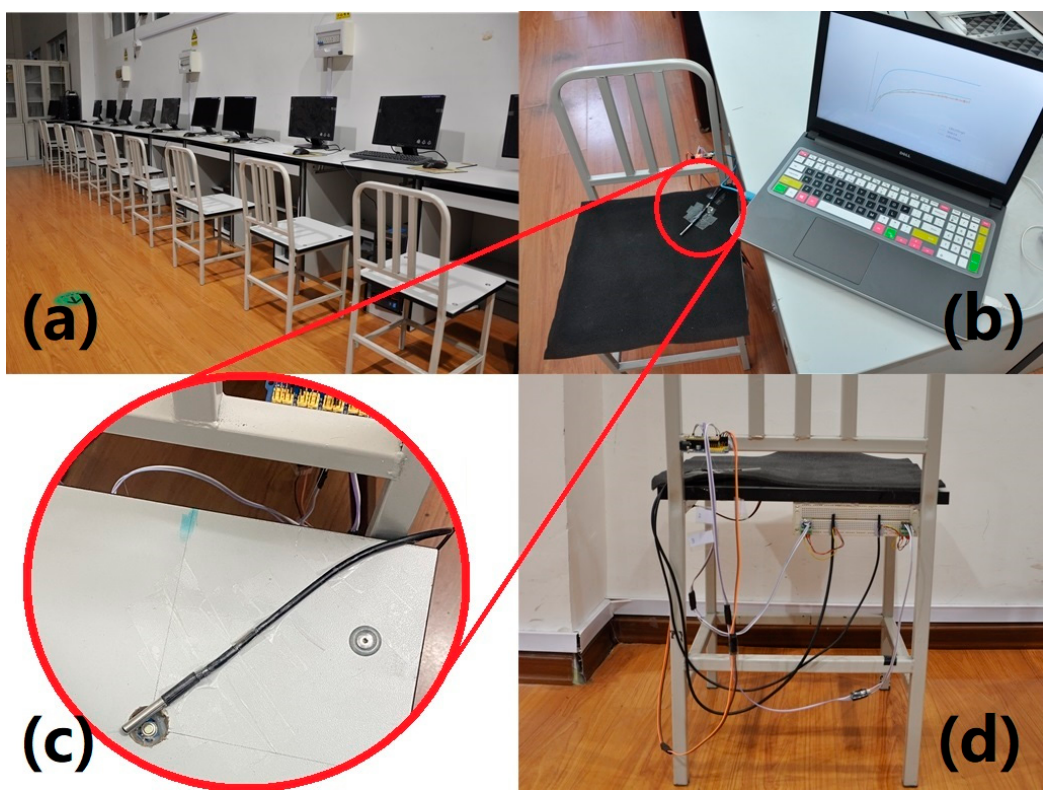
Figure 1. System construction of temperature measurement with temperature probe under the left ischial tuberosity and IRs directly beneath the cushion at the same location: ( a ) a perspective view of the research room with test chairs and computers; ( b ) top view of the experimental chair installed with 18B20 temperature probe (a water-proof metal cylinder which does not appear to significantly affect sitting comfort in asymptomatic users [19]) fastened onto the foam cushion by transparent tape; ( c ) IRs embedded in the wooden chair (to better illustrate the location of the IRs with respect to the temperature probe, the foam cushion has been removed); ( d ) rear view of the chair illustrating the data acquisition and data transmission elements.